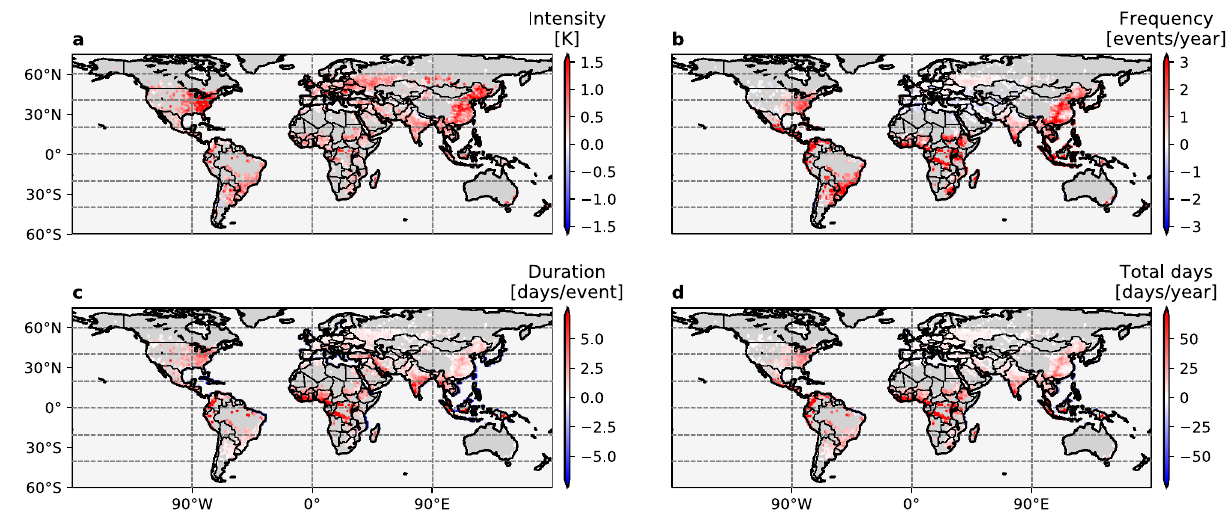
Fig. 1 Difference of the multi-model ensemble mean change of the local urban heat waves and the background regional heat waves in 2061 – 2070 relative to 2006 – 2015 under RCP 8.5. a intensity (K); b frequency (events per year); c duration (days per event); and d total days (days per year). Results are derived from the 17 selected Earth system models and the fi rst member of the CESM-LE runs. Colors indicate grid cells that have urban land; and there are in total 4439 such grid cells. Dark gray and light gray indicate grid cells without urban land. Each colored point represents a decadal mean urban-minus- background difference in 2061 – 2070 relative to 2006 – 2015 within a 0.9 ∘ (lat.) × 1.25 ∘ (lon.) model grid